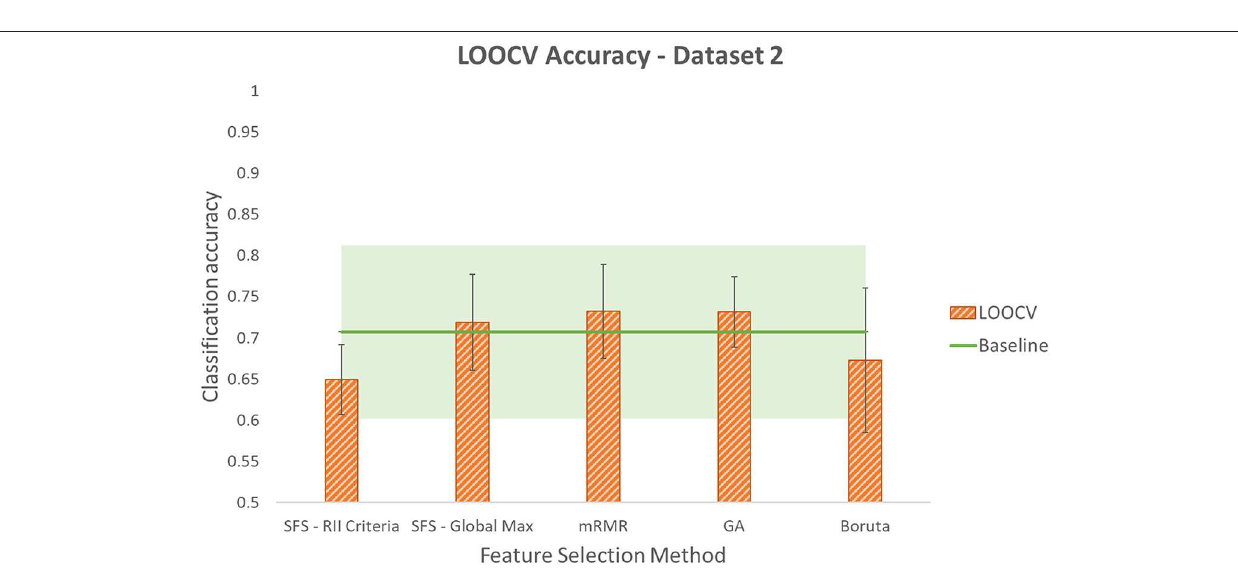
Table 4 . MRMR and SFS-RII criteria have the shortest run